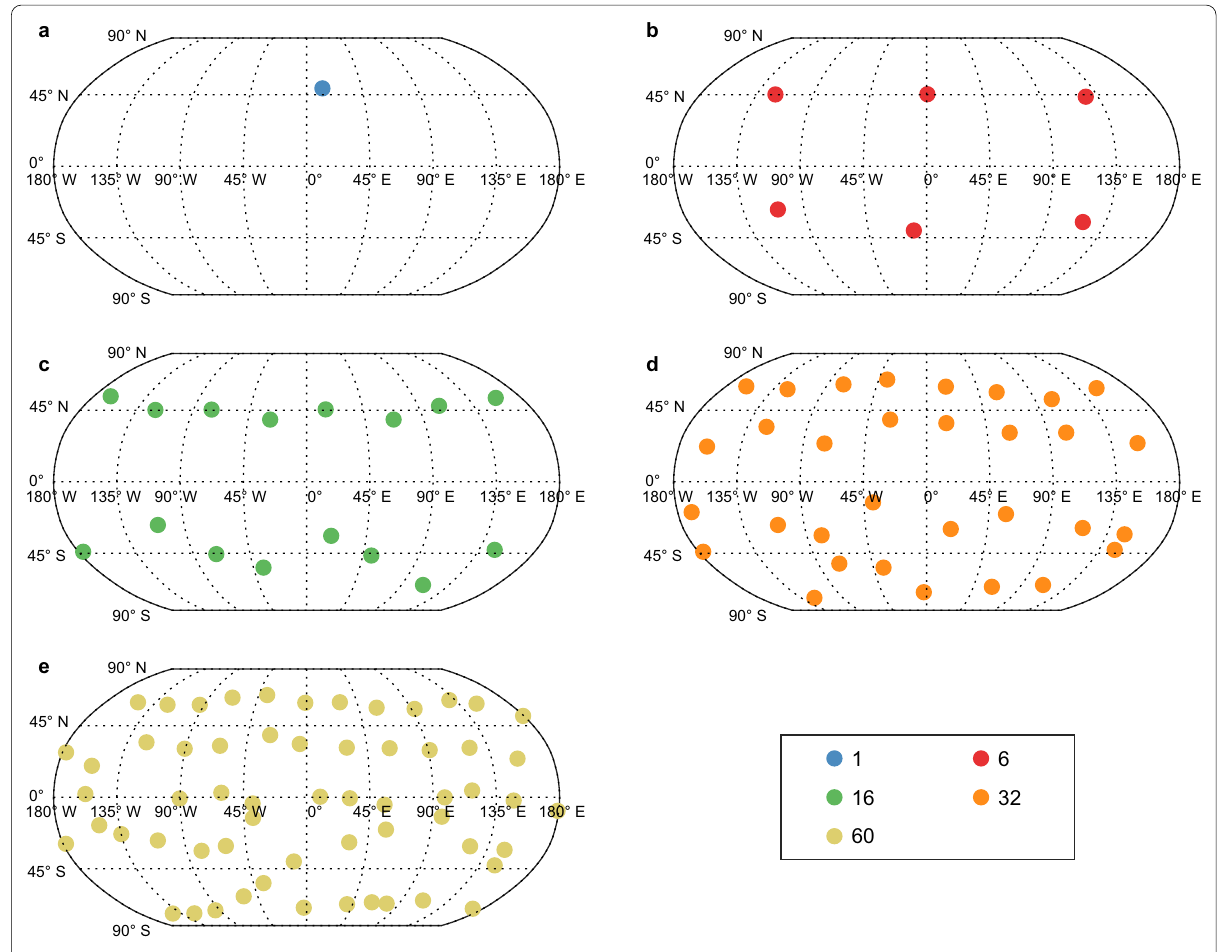
Fig. 5 Distribution of different number of ground stations for global networks: a 1, b 6, c 16, d 32 and e 60